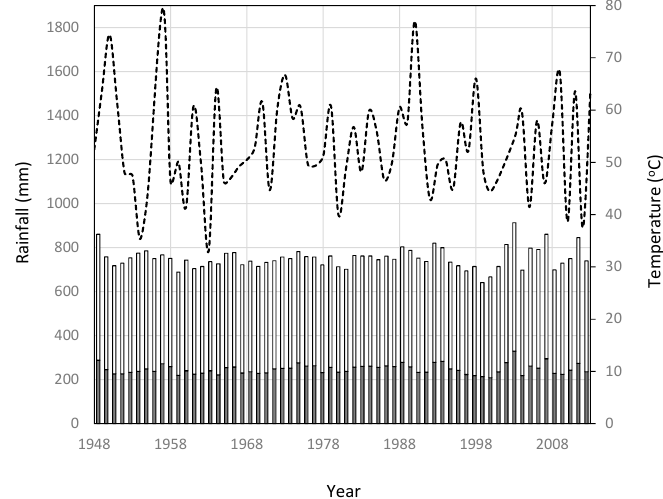
Figure 2. The long-term climatic variation in rainfall (dashed line) and temperature (column) in west Tennessee. Temperature columns show the mean monthly minimum (in black) and the mean monthly maximum (in white).